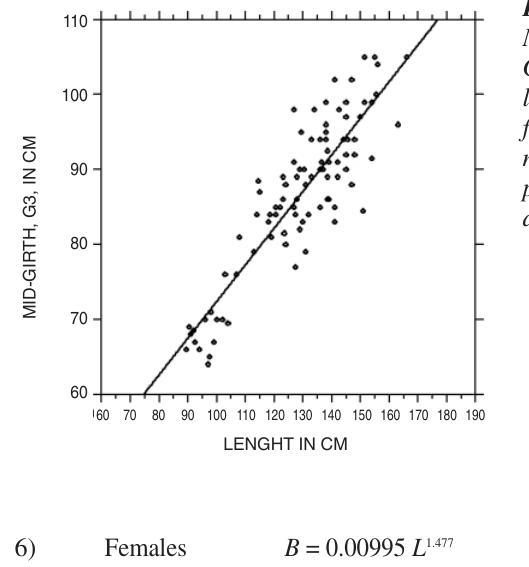
Fig. 10. Mid-girth, G 3 , at length for female and male por- poises, all